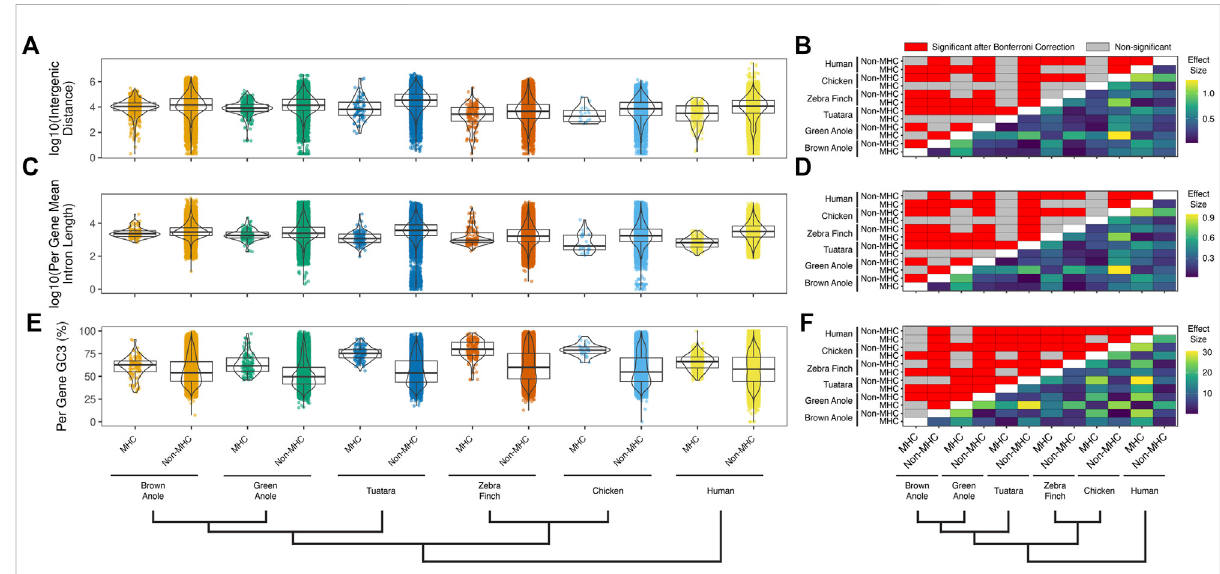
FIGURE 7 Quantitative comparisons of features of genomic composition in MHC vs non-MHC regions of six amniote species. Distributions of (A) intergenic distances per species and genomic region (log10 scaled) and (B) the results of pairwise statistical comparisons between all species and genomic regions. Distributions of (C) mean intron lengths per annotated genes for each species and genomic region (log10 scaled) and (D) the results of pairwise statistical comparisons between all species and genomic regions. Distributions of (E) per-gene GC3 for each species and genomic region and (F) the results of pairwise statistical comparisons between all species and genomic regions. Signi fi cant pairwise comparisons were based Dunn tests with Bonferroni-corrected p -values calculated across all three panels and all pairwise comparisons for repeat element composition(SupplementaryFigureS10)aresummarizedabovethediagonal(N=5,349comparisons; p ≤ 0.05;redcells).Differencesinthepairwise median measures of genomic composition (i.e., effect sizes) are summarized below the diagonal for each pairwise comparison. The color scales to therightofeachpanelindicatetheeffectsizeswithunitsbasedontheoriginalmetric(see y -axistitlesonpanels A , C ,and E ).SeeSupplementaryTable S11 for the summary statistics underlying intergenic distance, intron length, and GC3 distributions and the results of pairwise statistical comparisons between each genomic region (MHC and non-MHC) and amniote